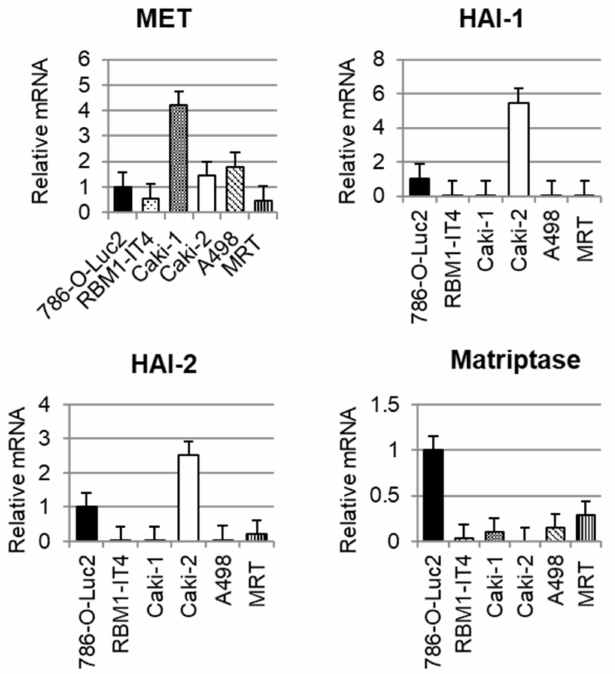
Figure 1. RT-qPCR analyses of MET, a c-met proto-oncogene product and receptor for hepatocyte growth factor (HGF), HGF activator inhibitor-1 (HAI-1), and HAI-2 and matriptase in six renal cell carcinoma cell lines. Glyceraldehyde-3-phosphate dehydrogenase (GAPDH) mRNA was used as the internal control.